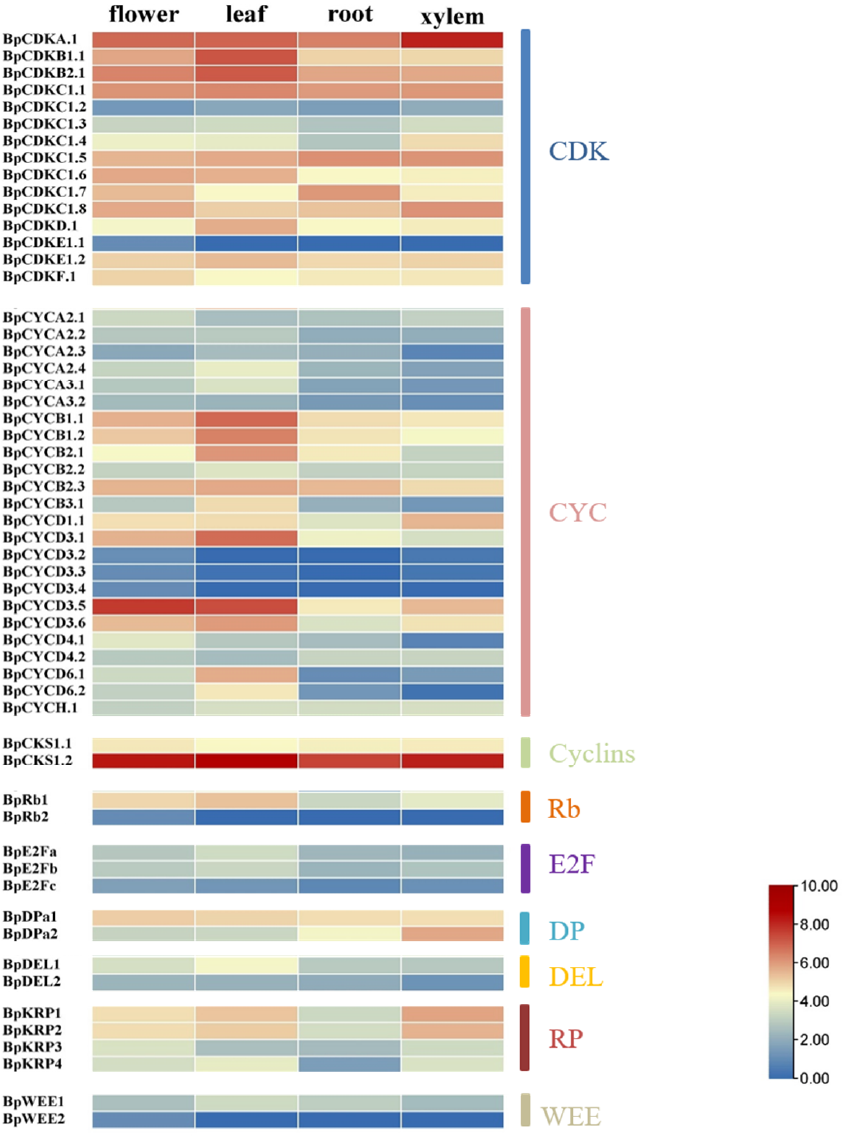
Figure 7. The heat map shows the expression of cell cycle genes in different parts of the birch tissue. Highly or lowly expressed genes are colored red or blue, respectively.